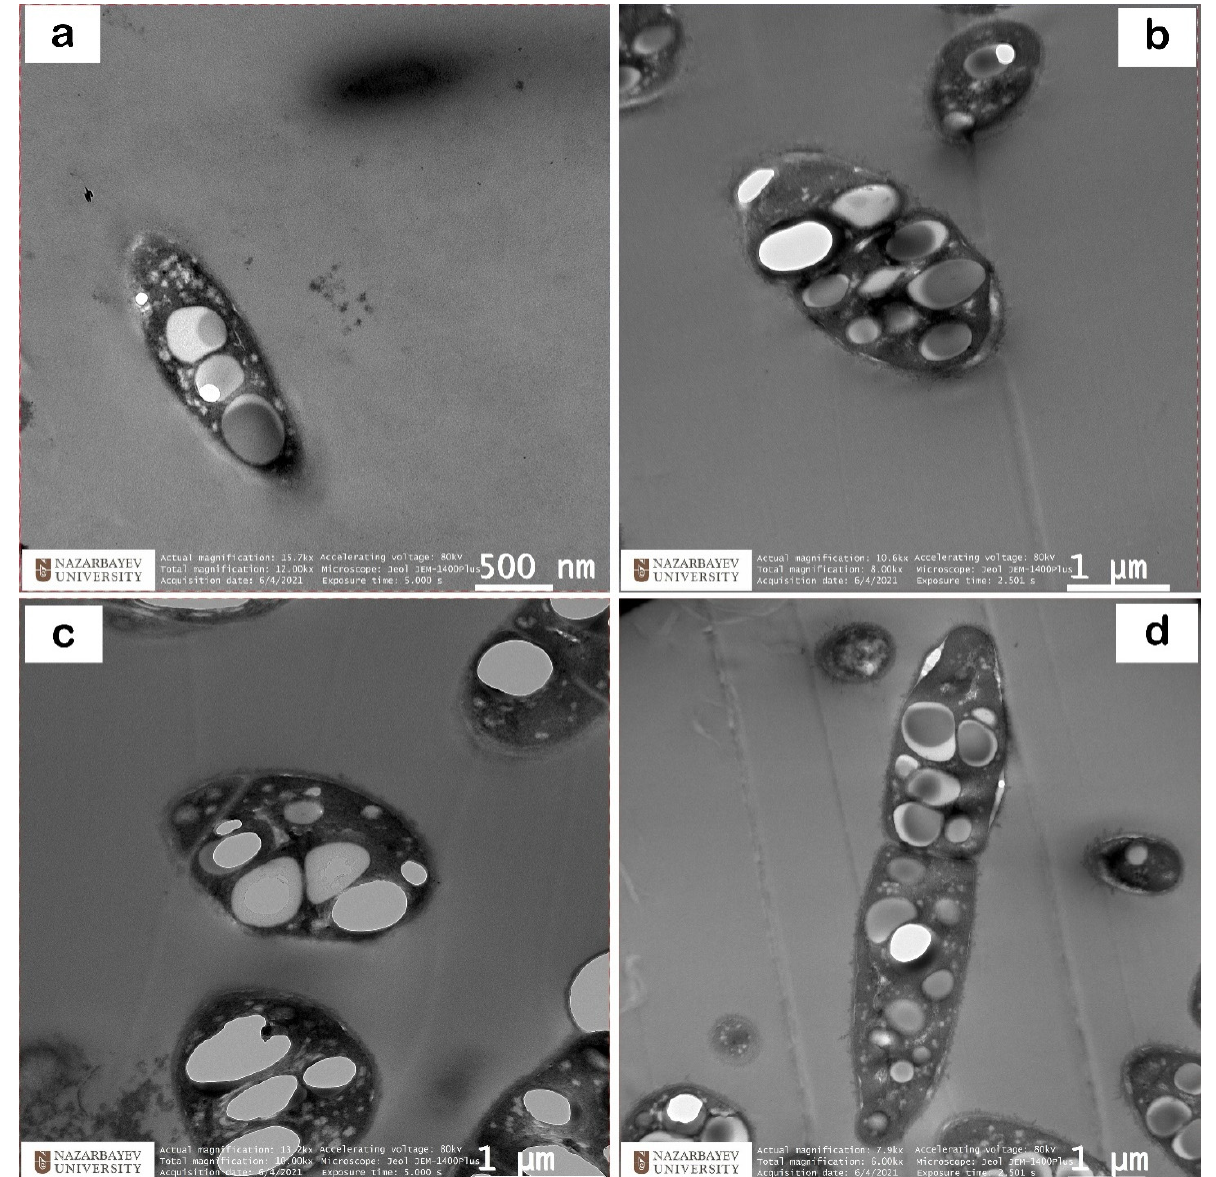
Figure 5. DARK images of bacterial isolates producing P(3HB) after twelve hours of incubation: half-day cultures ( a ) RA 1, ( b ) RAZ 3, ( c ) RA 5 and ( d ) RAF 5. The white granules inside the bacterial cells represent the P(3HB) granules accumulated inside them.